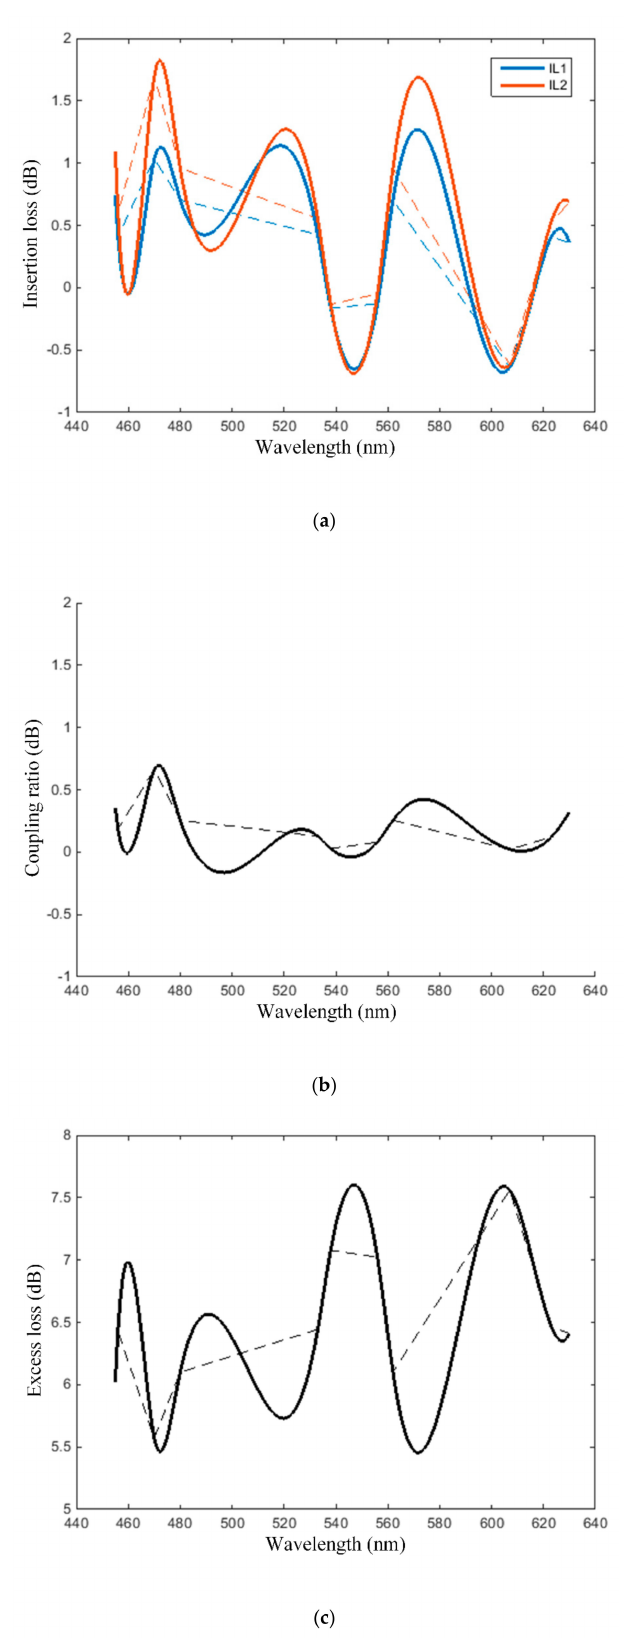
Figure 9. Spectral attenuation measures of the point intra-oral optical sensor expressed in terms of: ( a ) insertion loss, ( b ) coupling ratio, ( c ) excess